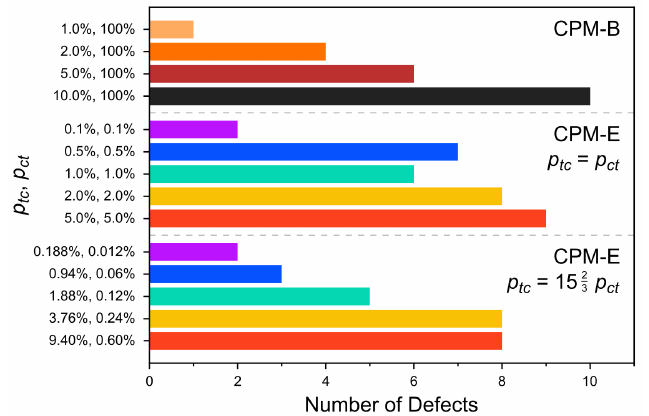
Figure 7. Number of defects in the cluster during the final 50 of 500 cycles (last 2.4ns of 24ns in total) of each simulation run. Results for different switching probabilities both in the CPM-B and CPM-E approach are shown. The defect detection algorithm is described in the Supplementary Material.